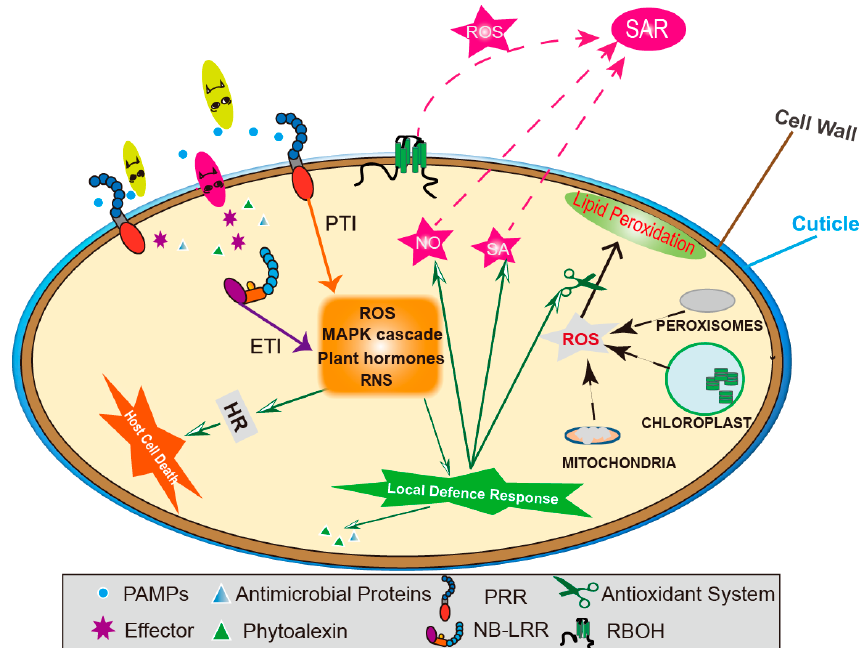
Figure 1. A model of plant immunity to pathogenic microorganism infection. The invading pathogenic microorganisms are first subject to plant physical (the outermost cuticle and epicuticular wax together with the lignified cell wall) and chemical barriers (phytoalexin and antimicrobial proteins). Simultaneously, the pattern recognition receptors (PRRs) located at the membrane recognize pathogen-associated molecular patterns (PAMPs) to induce PAMP-triggered immunity (PTI), while the nucleotide-binding leucine-rich repeat (NB-LRR) proteins recognize effectors delivered by pathogens and induce effector-triggered immunity (ETI). The PTI and ETI activate downstream defence including the local defence response and host cell death, mediated by a series of signal or regulatory factors (such as reactive oxygen species (ROS), reactive nitrogen species (RNS), mitogen-activated protein kinase (MAPK) cascades and hormones). The antioxidant systems are also stimulated to maintain intracellular redox balance. Furthermore, signals including nitric oxide (NO), salicylic acid (SA) and NADPH oxidase (RBOH)-generated ROS act to induce systemic acquired resistance (SAR) in uninfected tissues.